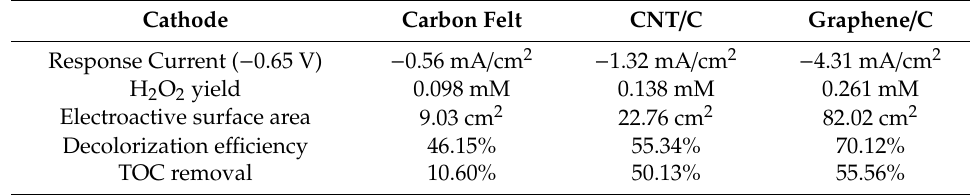
Table 1. Decolorization efficiency and total organic carbon (TOC) removal after 30 min of the electro-Fenton treatment proposed in this work (40 ppm Reactive Black 5 (RB 5)).